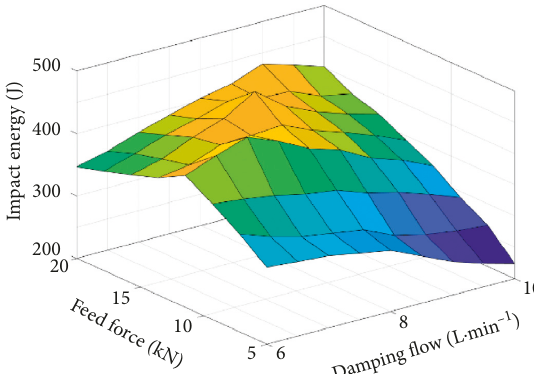
Figure 10: The comparisons of drilling power under different combinations ( Q d , F d